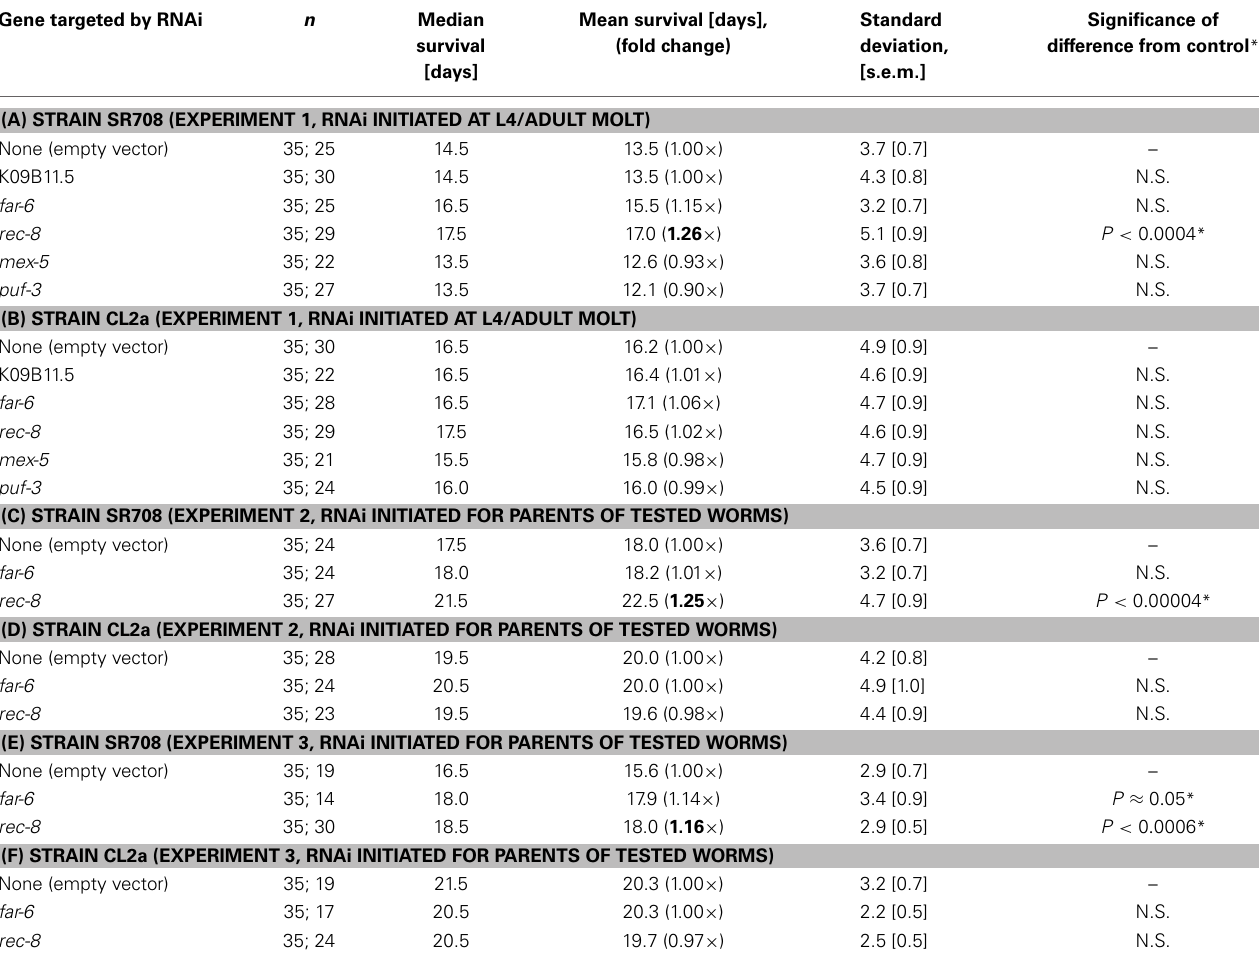
Table 4 | Survival data for near-isogenic strains SR708 and CL2a, fed on E. coli expressing the indicated dsRNAs. Gene targeted by RNAi n Median